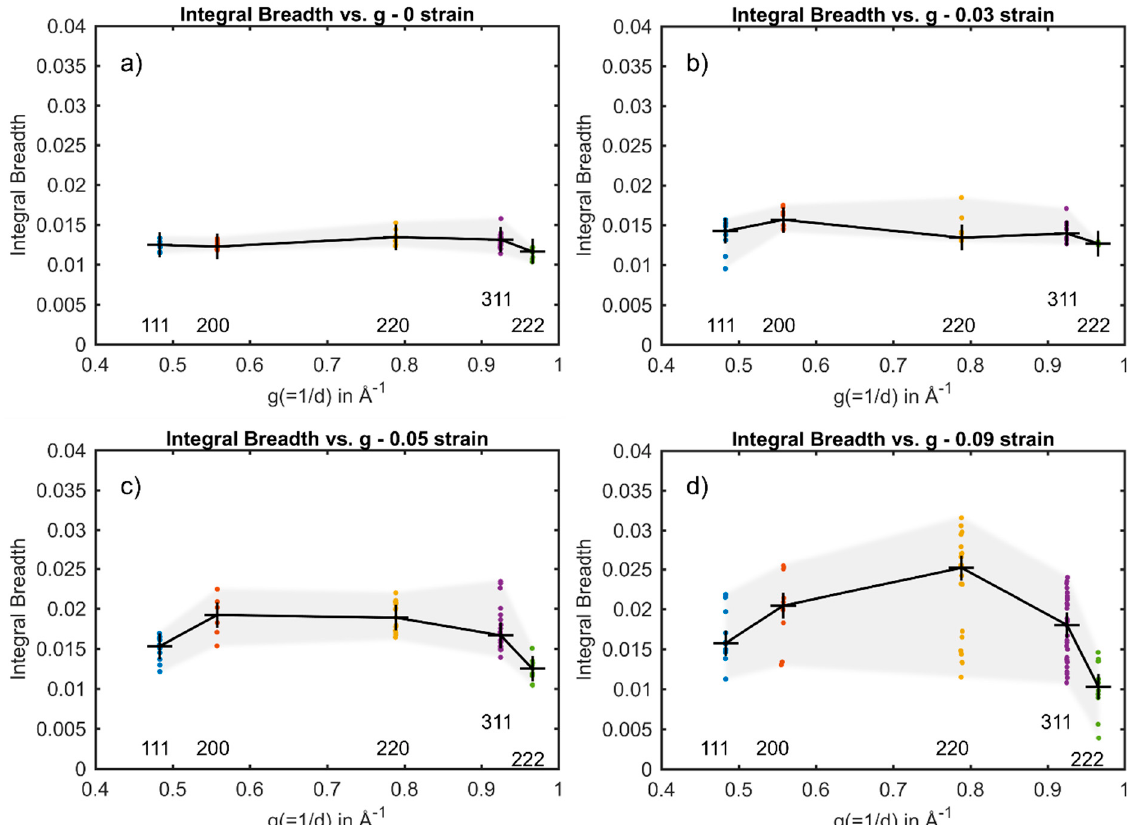
Figure 4. Integral breadth as a function of g for grain #29 at ( a ) 0 nominal strain, ( b ) 0.03 nominal strain, ( c ) 0.05 nominal strain and ( d ) 0.09 nominal strain. Table 2. α determined utilizing the modified and regular WH plot in individual grains. Nom.